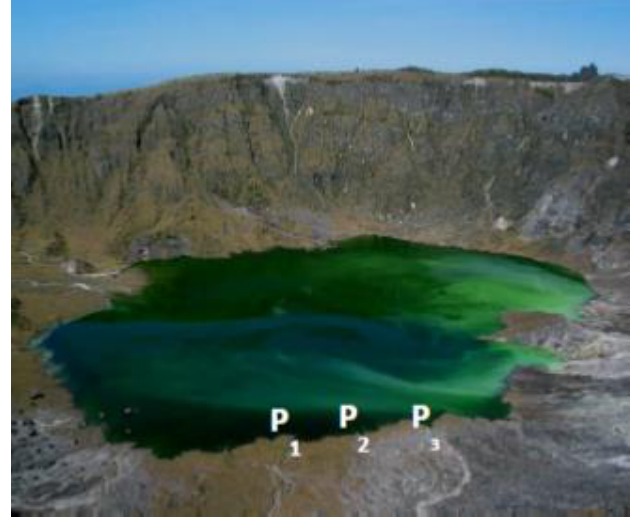
Figure 1. Sampling sites of the geothermal water in the El Chichón volcano crater lake.